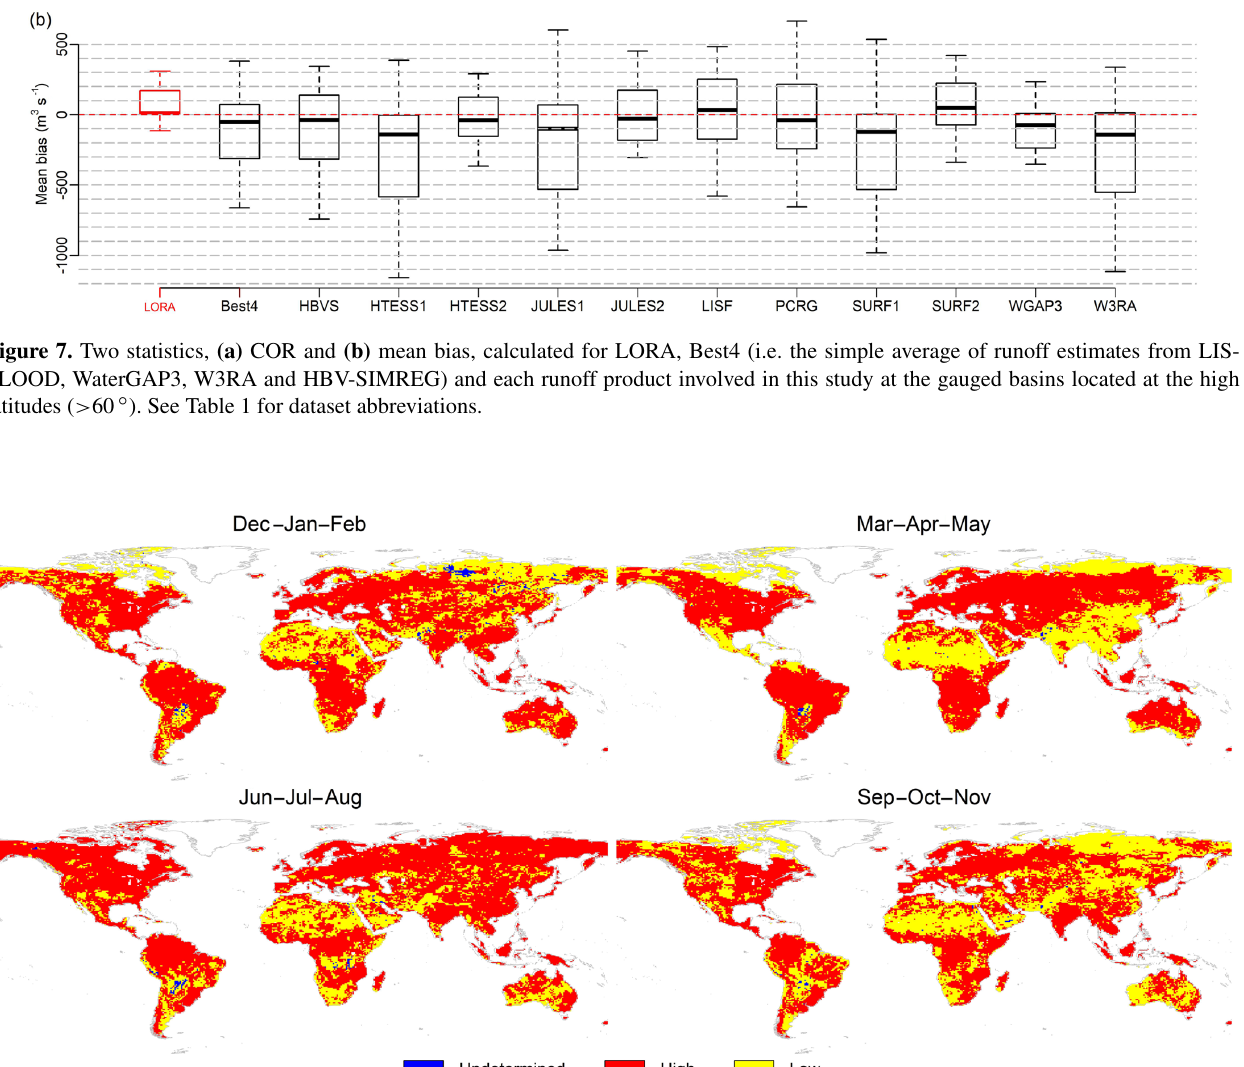
Figure 8. Seasonal reliability, defined as high ( mean runoff uncertainty mined (mean runoff = 0, in